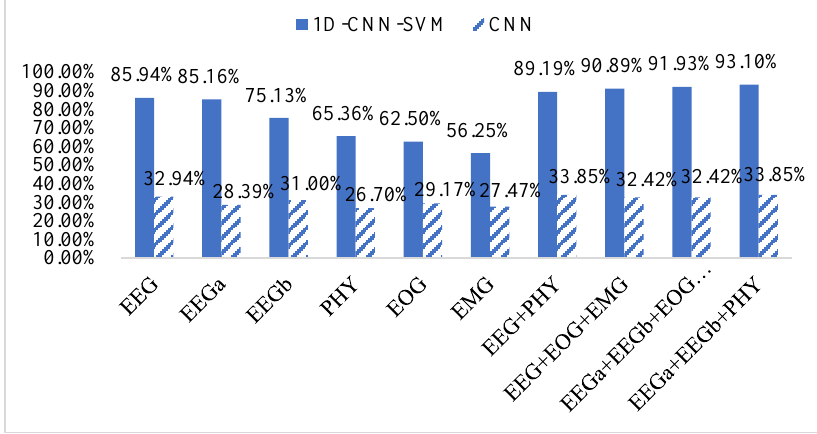
Fig. 3. Comparison of accuracy of emotional recognition models with different data splicing